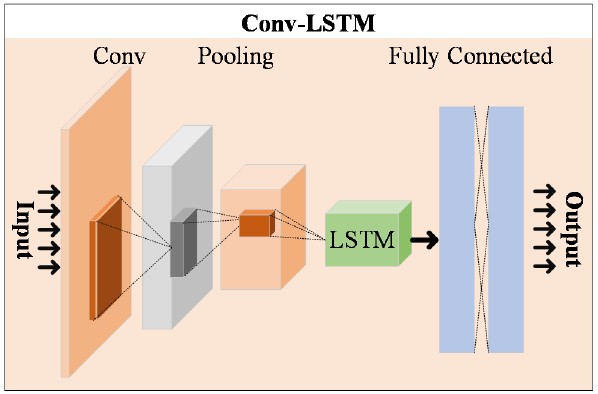
Figure 4. The applied Conv-LSTM mode.